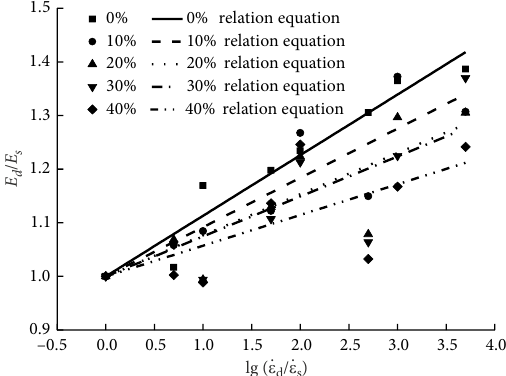
Figure 13. Effect of strain rate on elastic modulus improvement